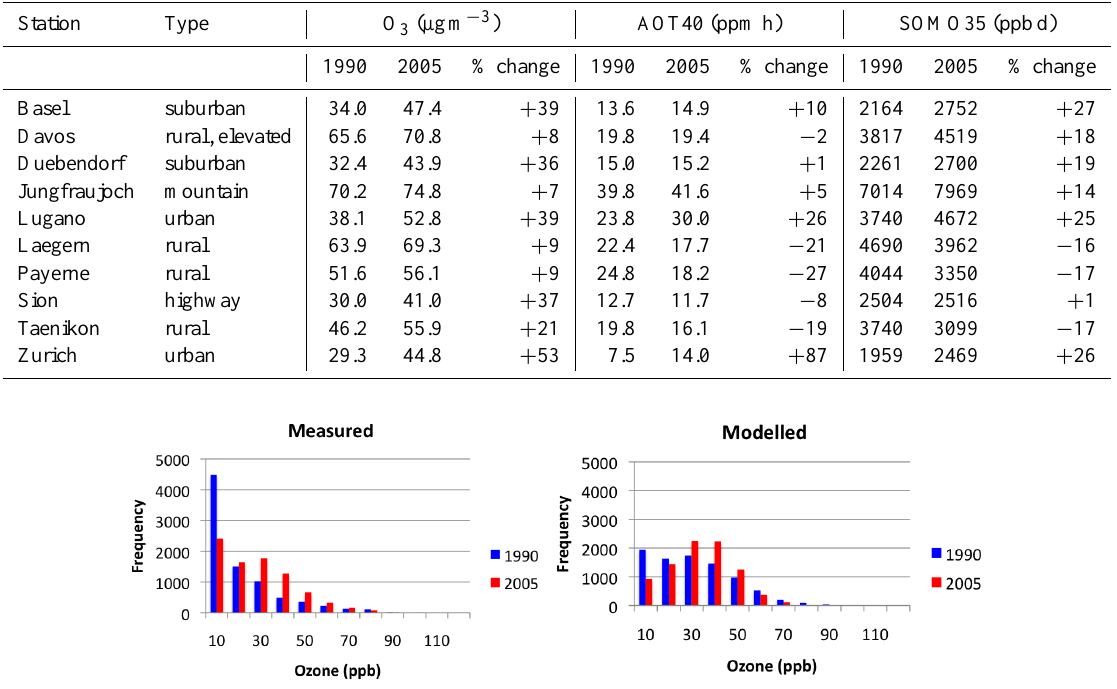
Figure 8. Changes in frequency distributions of measured (left) and modelled (right) ozone between 1990 and 2005 in